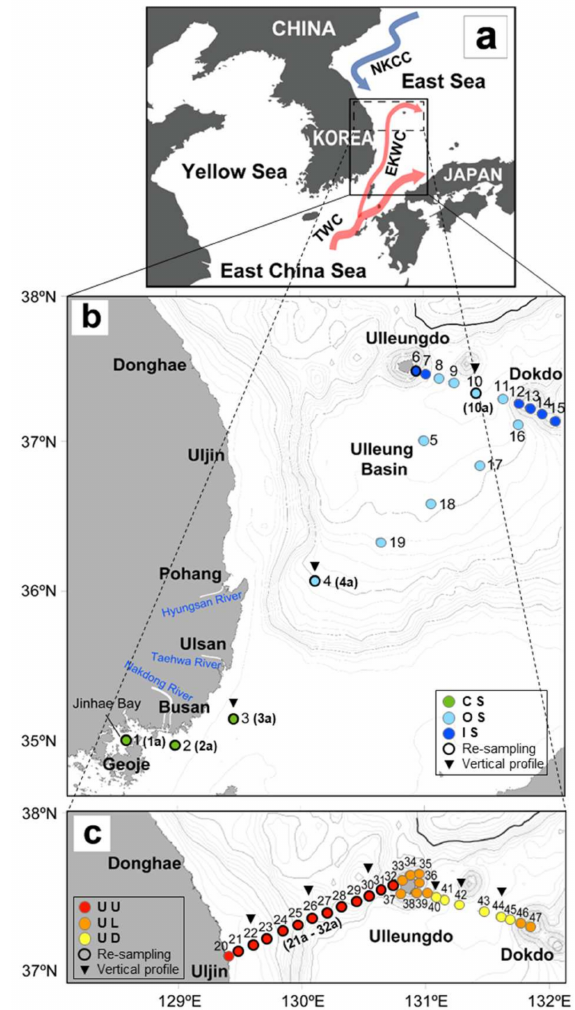
Figure 1. Overview of the East Sea, showing the main water currents (Tsushima Warm Current [TWC] and East Korea Warm Current [EKWC]) in red arrows and the North Korea Cold Current (NKCC) in a blue arrow ( a ). Locations of sampling stations during early spring ( b , 27 February to 5 March) and late spring ( c , 2 to 7 June). Dots are color-coded ( b , green: CS, light blue: OS, dark blue: IS; c , red: UU, orange: UL, yellow: UD). A black outline on a colored dot indicates re-sampled stations on the return trip. Re-sampled stations are marked with an “a” meaning “after time lag”. Inverted triangles represent the vertical surveyed stations using